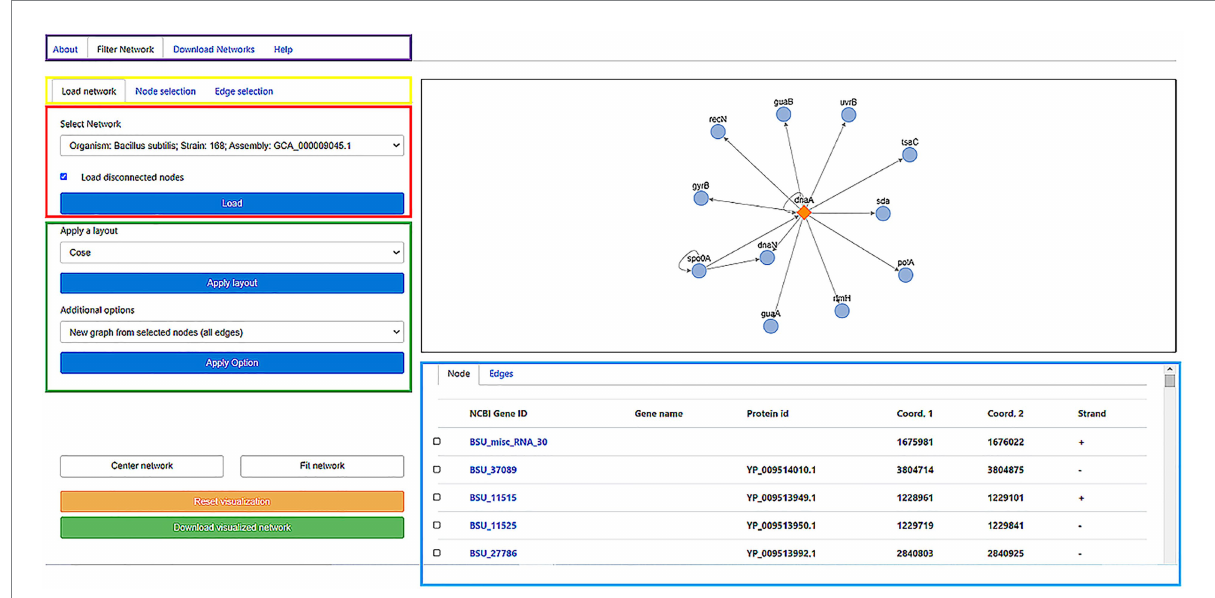
FIGURE 2 Online interface of the “regulatory networks” server storing the publicly available database. Diverse options are available for the user: a description of the system, a page to download the raw data, and the core section of the web to filter a GRN (purple box). To visualize load a network, the user can select the Gene Regulatory Network of the organism of interest in the “load a network” panel. In the Select network box, the user can Start selecting the name of the organism and click on the Load button to visualize the network on the right window (red box). This action will load the graph (black box) and node/edges properties (cyan box). Diverse layouts can be applied to visualize the network and specific nodes/edges to generate a new subgraph (green box) can be selected. As the graph visualization could be modified, the user can center/fit the network (White buttons) or reset the current visualization (Yellow button). Finally, for displayed nodes and edges, the user can download this network (Green button). In the example, in the right panel, the network is associated with the transcription factor DnaA (diamond) and their Target Genes (circles). Edges represent the transcription direction (when it is available). In the low panel, the TGs under the regulation of the TF are shown: NCBI ID, gene name, protein ID, start and end position, and strands. For more details of the web application, please refer to the Supplementary